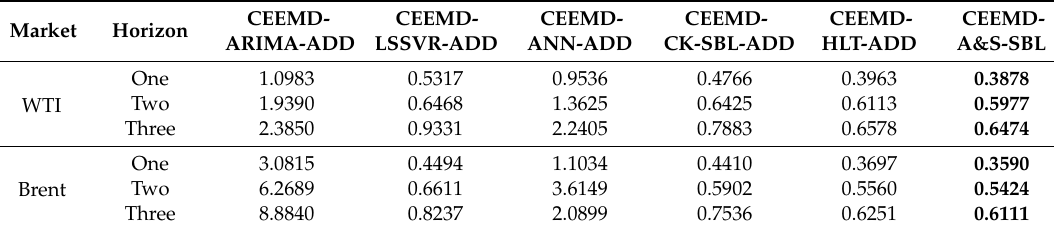
Table 4. The root mean squared error (RMSE) values of different prediction models on WTI and Brent crude oil prices.